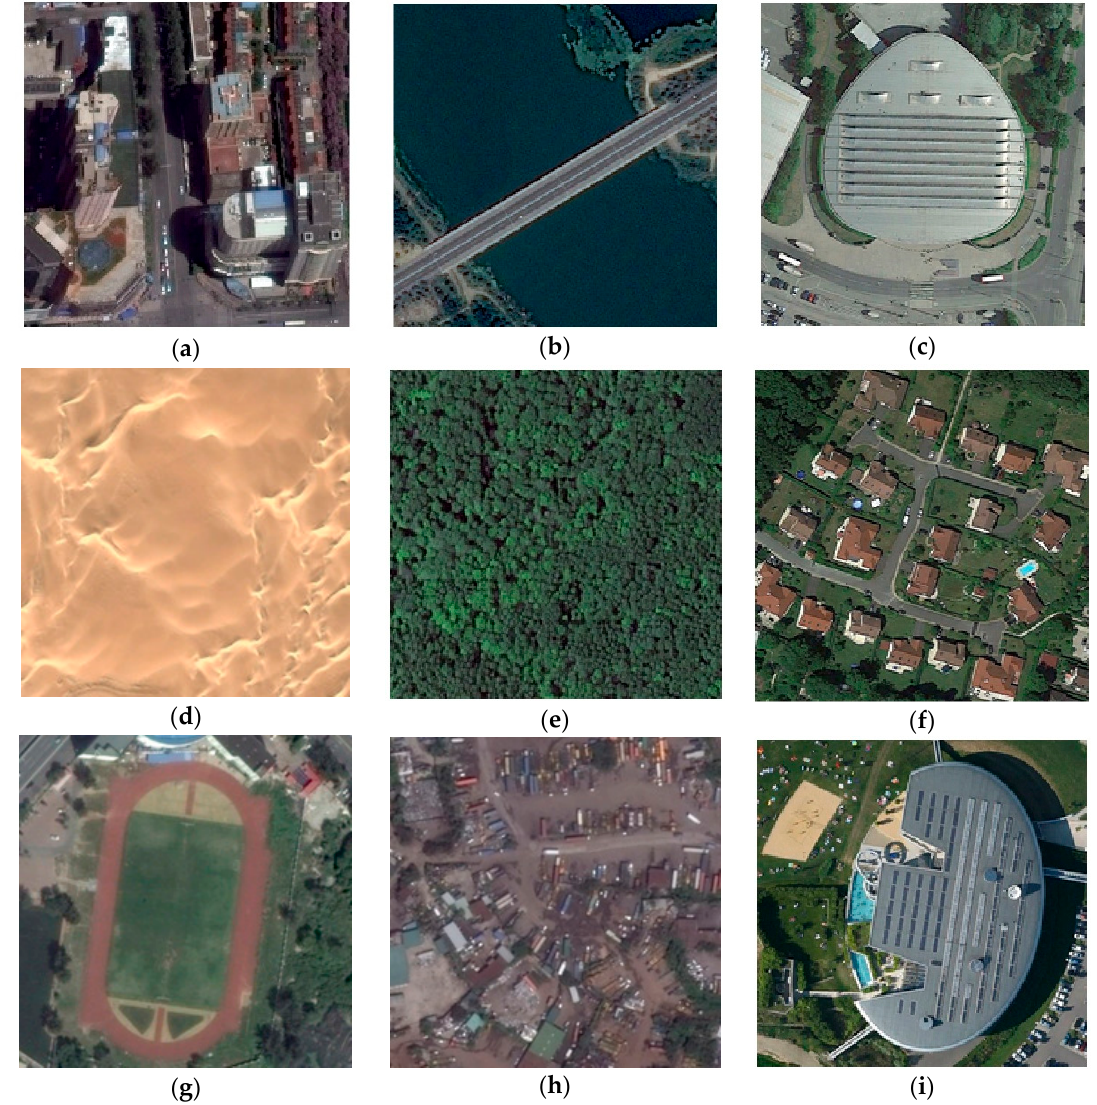
Figure 9. Some results using our model on RSICD. ( a ) many buildings and some green trees are in a commercial area. ( b ) a bridge is on a river with some green trees in two sides of it. ( c ) some buildings and green trees are around a circle center building. ( d ) many ripples are in a piece of yellow desert. ( e ) many green trees are in a piece of forest. ( f ) many building and green trees are in a medium residential area. ( g ) a playground is surrounded by many green trees and buildings . ( h ) many buildings and some green trees are in a commercial area. ( i ) many buildings are around a circle square.